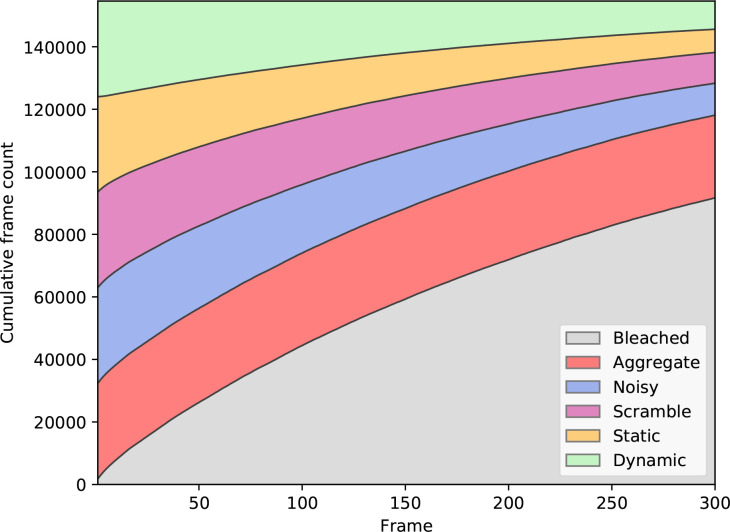
Training label dependence on the frame number.The distribution of labels for all frames in the training dataset, after balancing classes based on the first frame. The ‘bleaching’ label is excluded from balancing, as it occurs in most of the generated traces, due to photobleaching.